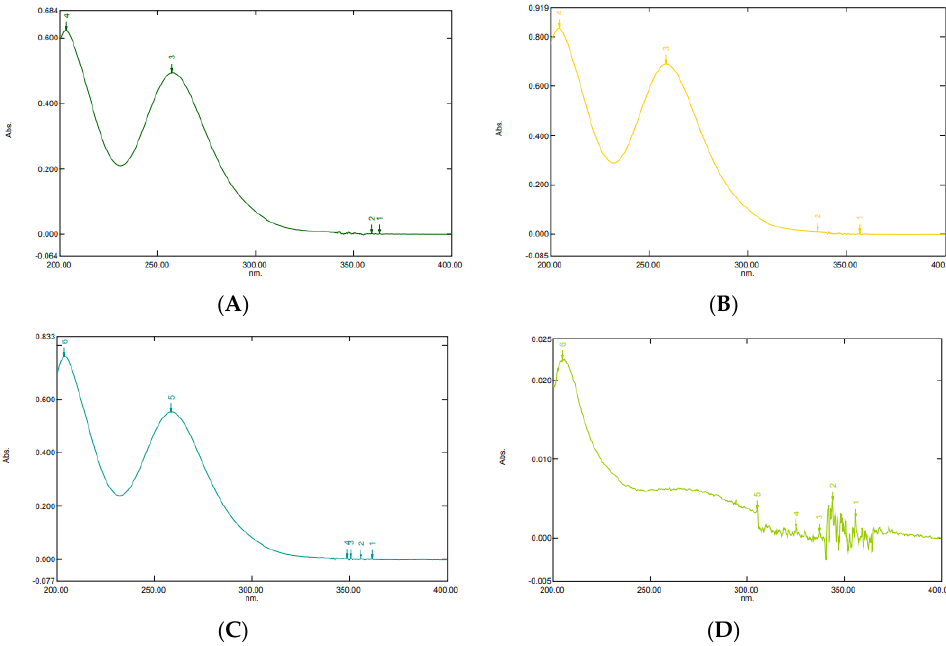
Figure 1. Absorption spectra of ketoprofen analyzed by spectrophotometer UV − Vis. ( A ) Ketoprofen standard. ( B ) Ketoprofen − PVA mixture. ( C ) Ketoprofen − PVP mixture. ( D ) Blank sample.